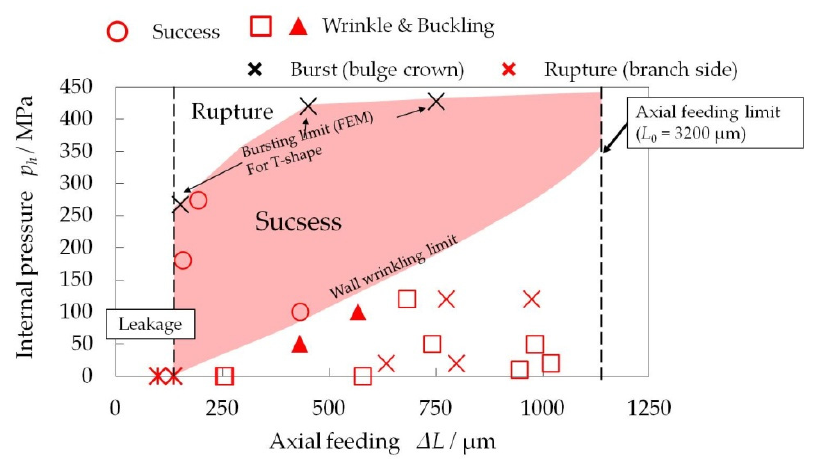
Figure 22. Process window for T ‐ shape MTHF (C1220).